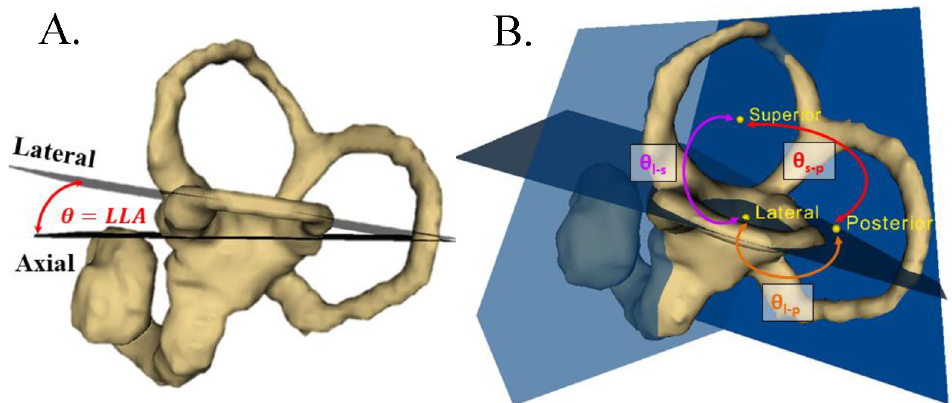
Fig 2. SCC angle measurements. (A) Angle ( θ ) between the axial and best-fit left lateral canal planes (LLA) on the reconstructed study surface. (B) Angles between each canal best-fit plane: θ l−s = angle between lateral and superior = angle between lateral and posterior SCCs, θ = angle between superior and posterior SCCs, θ l−p s−p